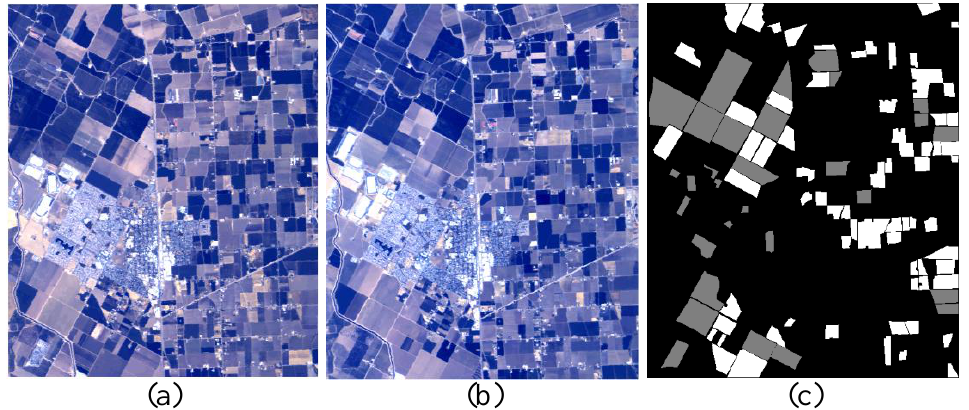
Figure 3. Bay dataset: ( a ) T 1 -time image, ( b ) T 2 -time image, and ( c ) reference image. (Notation: gray color, white color, and black color denote unchanged pixels, changed pixels, and uninteresting pixels, respectively).